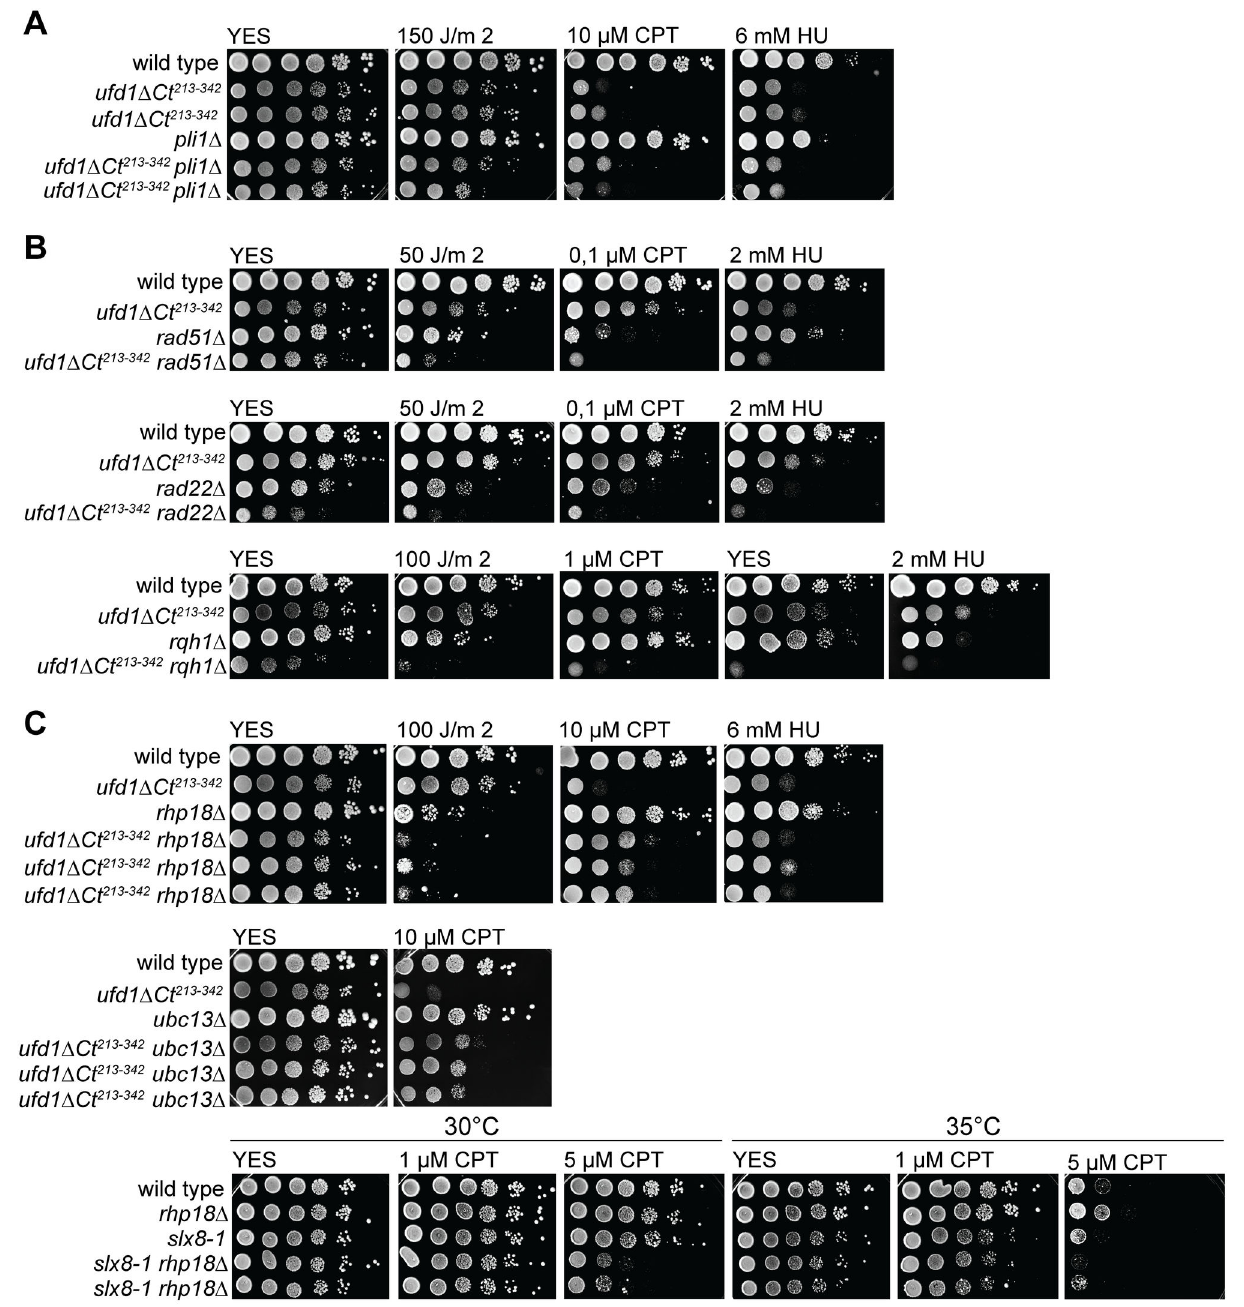
Figure 5. Epistasis analysis of the ufd1ΔCt 213-342 mutation with mutations in DNA repair or STUbL pathway. (A, B, C) 10-fold serial dilutions of the indicated strains were spotted onto YES plates with or without DNA-damaging agents as indicated, or onto plates subsequently exposed to UV irradiation. (A) Epistatic relationship of ufd1ΔCt 213-342 with pli1Δ indicates non-overlapping functions of Ufd1 and the STUbL pathway. (B) Negative genetic interactions between ufd1ΔCt 213-342 and mutations of HR repair proteins. (C) Partial suppression of ufd1ΔCt 213-342 CPT sensitivity by rhp18Δ and ubc13Δ .